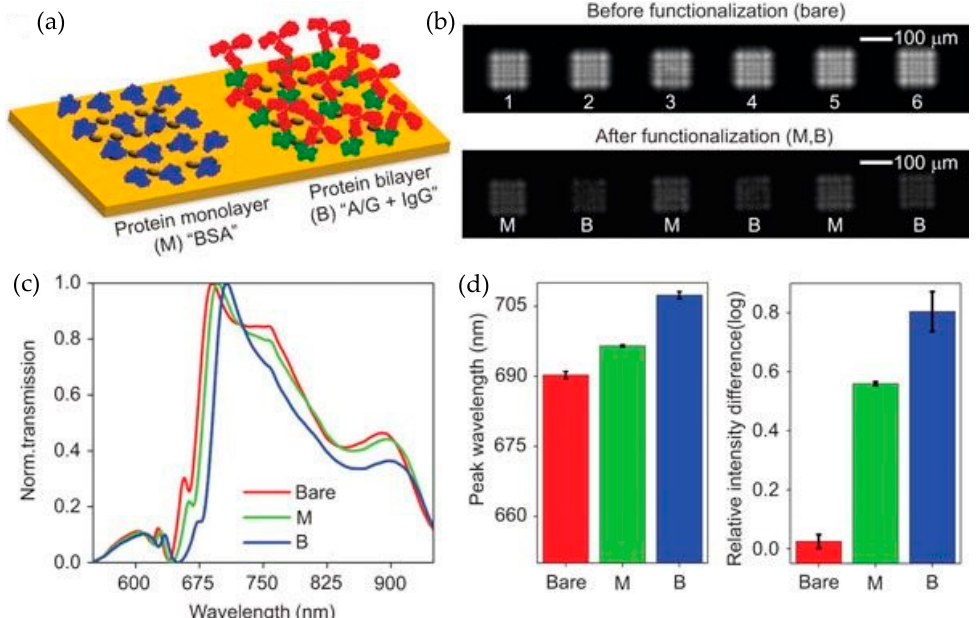
Figure 13. Experimental results detailed in Cetin et al. [77]. ( a ) Schematic of the performed protein assay. ( b ) Recorded lens free diffraction patterns of the bare nanohole array (top) and when mono (0.5% v/v BSA) and bi layer protein (0.5 mg/mL protein A/G + 0.5 mg/mL protein IgG) were deposited on the metallic nanoholes array (bottom). ( c ) Wavelength shift when mono and bi layers of protein were deposited on the metallic nanohole array (measured by an OSA). ( d ) Peak wavelength shift estimated from the lens free diffraction image patterns by relating resonance wavelength shift measured by the OSA shown in ( c ) and relative intensity difference of the diffraction patterns when mono and bi layer proteins are deposited shown in ( b ). Reprinted with permission from [77]. Copyright © CIOMP (2014).